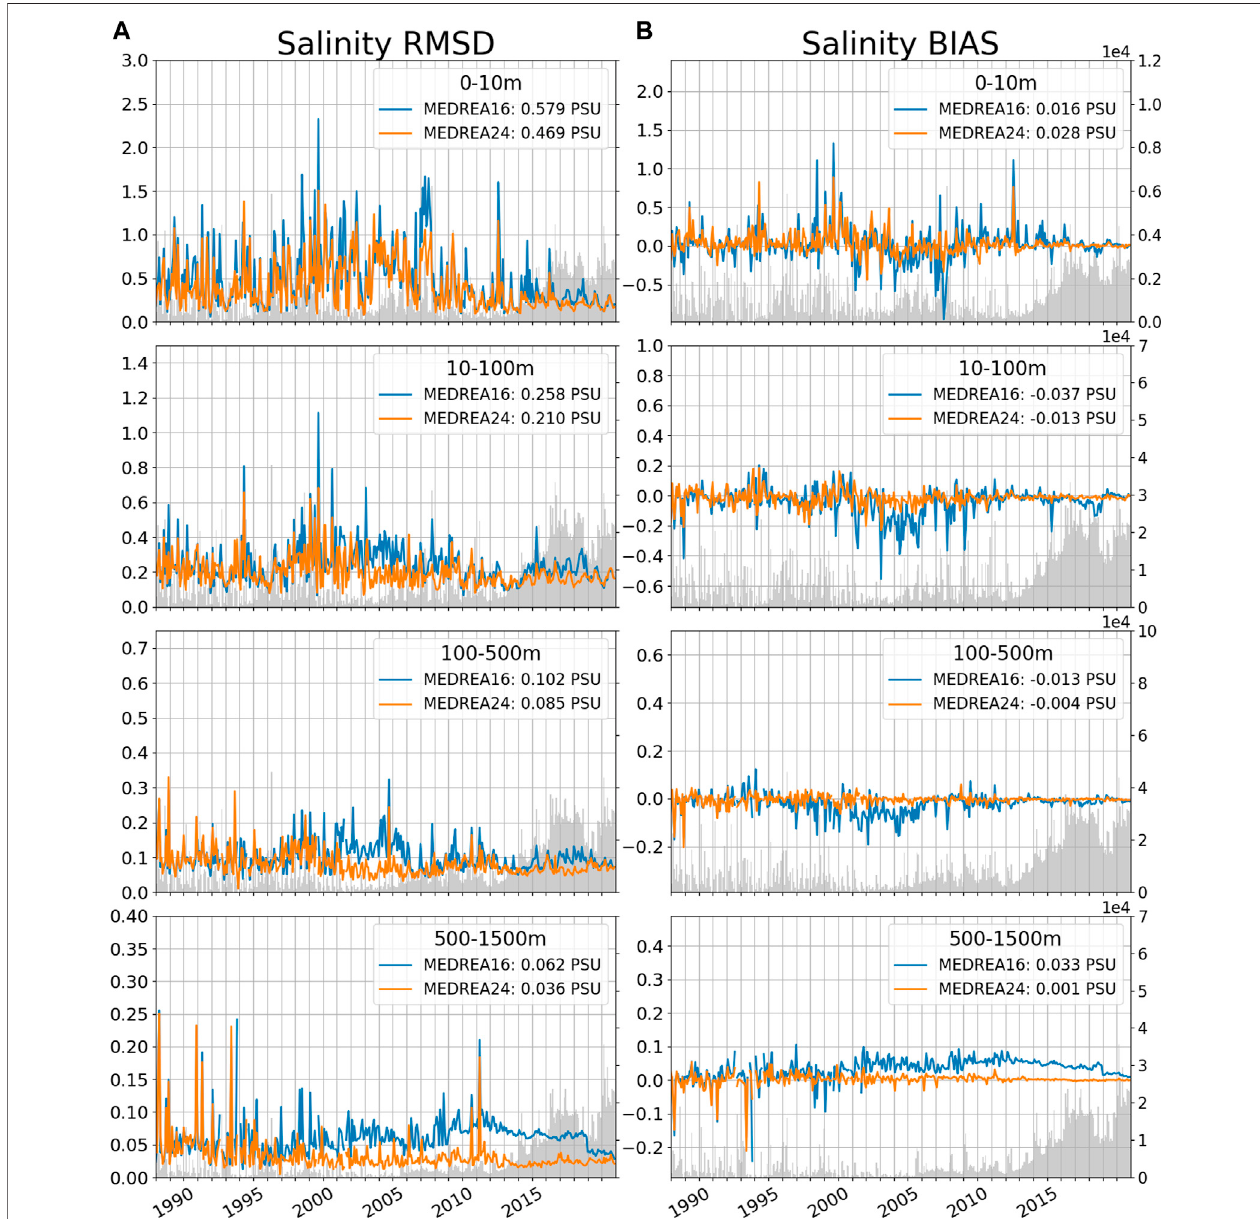
FIGURE 6 | Monthly salinity RMSD (A) and bias (B) (in PSU) for the two reanalyses and the hindcast when compared to observed pro fi les for different layers. The values of RMSD/bias for the whole period are indicated in the legend. The shaded area represents the number of observations for each month (axis is on the right). Note the different y -axis in the different